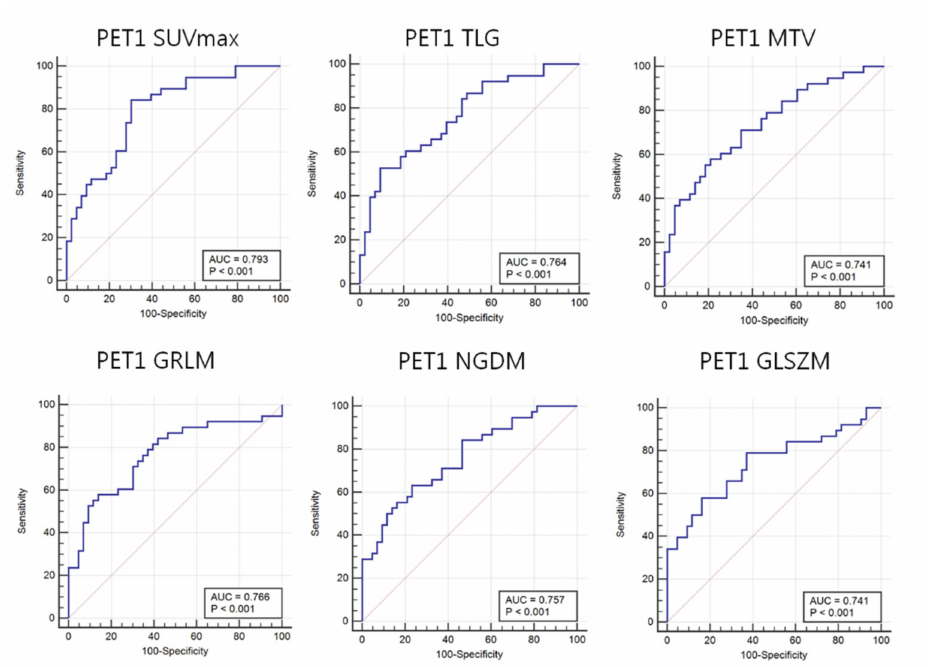
Figure 5. Area under the receiver operating characteristic curves (AUC) for 18 F-FDG heterogene- ity features in PET1. Maximum standardized uptake value (SUVmax), total lesion glycolysis (TLG), and metabolic tumor volume (MTV) as well as 18 F-FDG uptake heterogeneity features such as image voxel alignment heterogeneity (GLRIM_HGHGE), image neighborhood intensity difference (NGLDM_SNE), and image intensity size zone (GLSZM) can predict the response to neoadjuvant